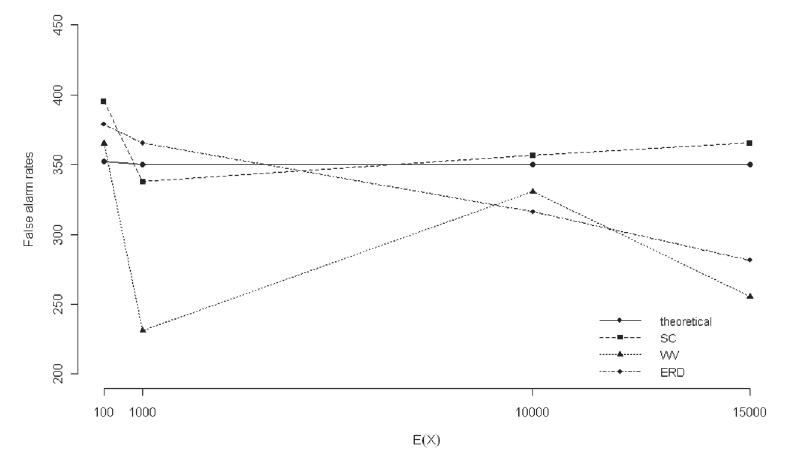
Figure 5 – Estimated ARLs 